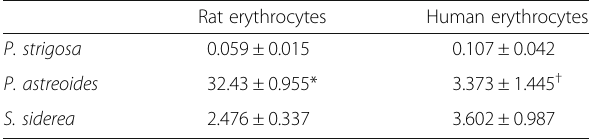
Table 3 Vasoconstrictor activity of the aqueous extracts in isolated rat aortic